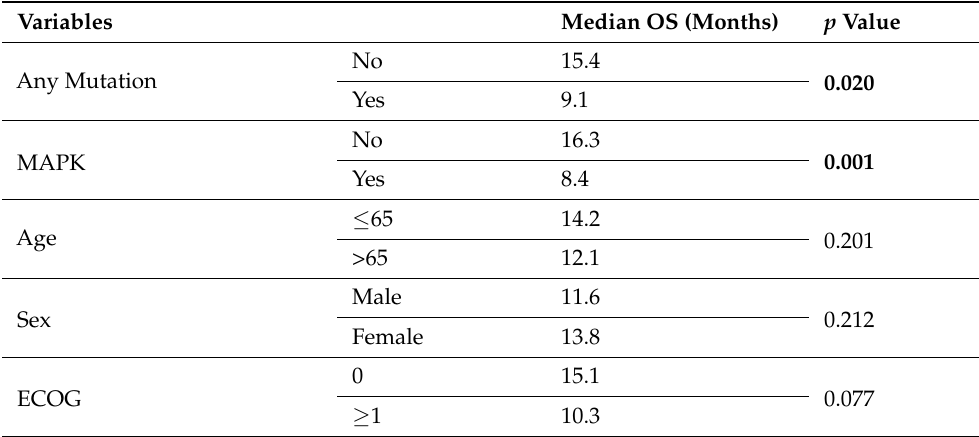
Table 3. Overall Characteristics and Median Overall Survival from Hepatic Metastasis. Variables